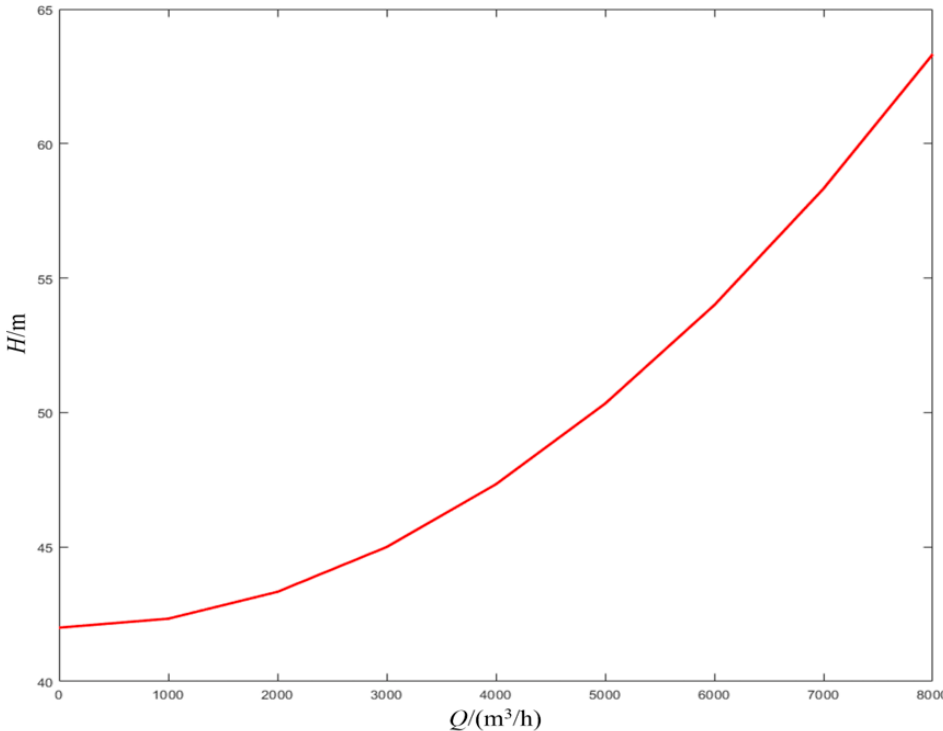
Figure 8. Actual hydraulic demand curve of the system.